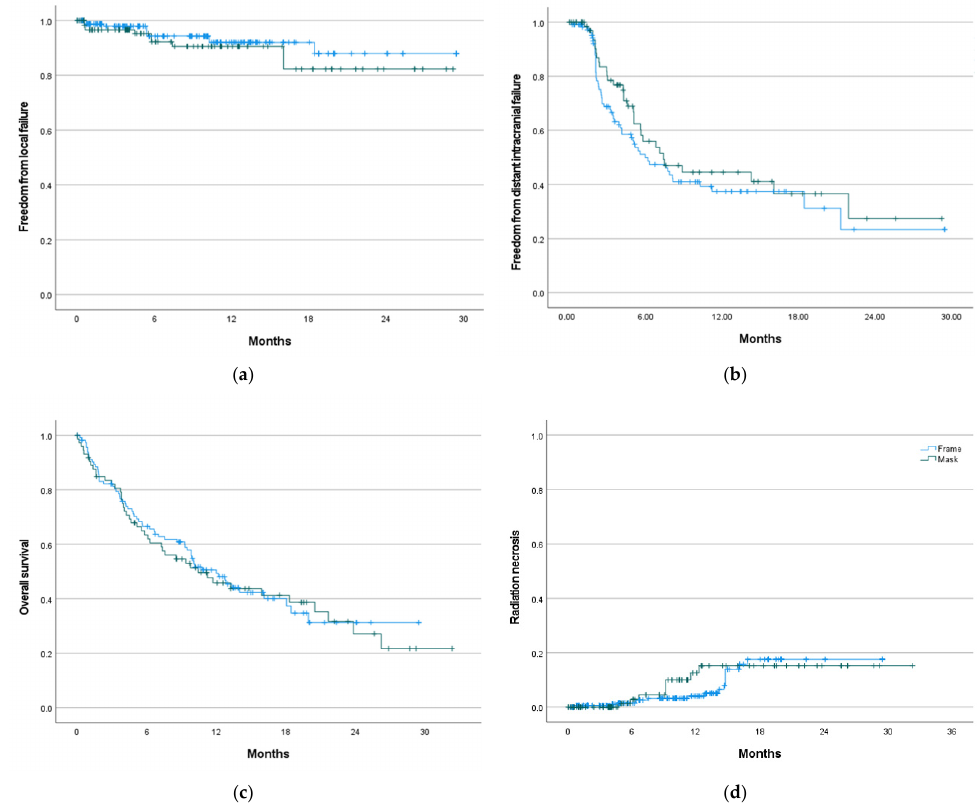
Figure 2. Freedom from local failure ( a ), freedom from distant intracranial failure ( b ), overall survival ( c ), and incidence of radiation necrosis ( d ), by frame- vs. mask-based immobilization with zero-PTV margin.